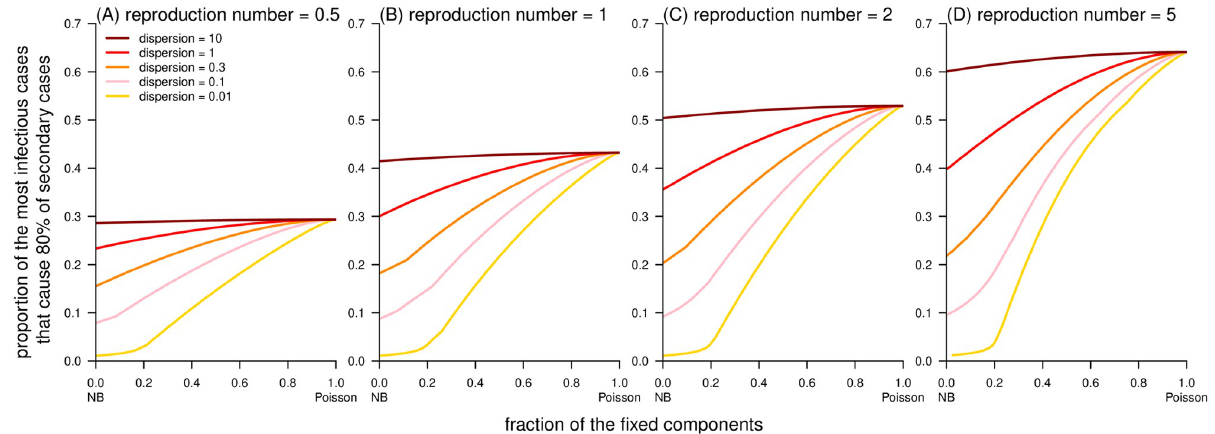
Fig 2. Simulation results of the proportion ( P ) of the most infectious cases that cause ( Q =) 80% of secondary cases as a function of fraction of fixed component ( ρ ) generated from Delaporte distributions. The ‘NB’ in the horizontal axis label stands for negative binomial (distribution).